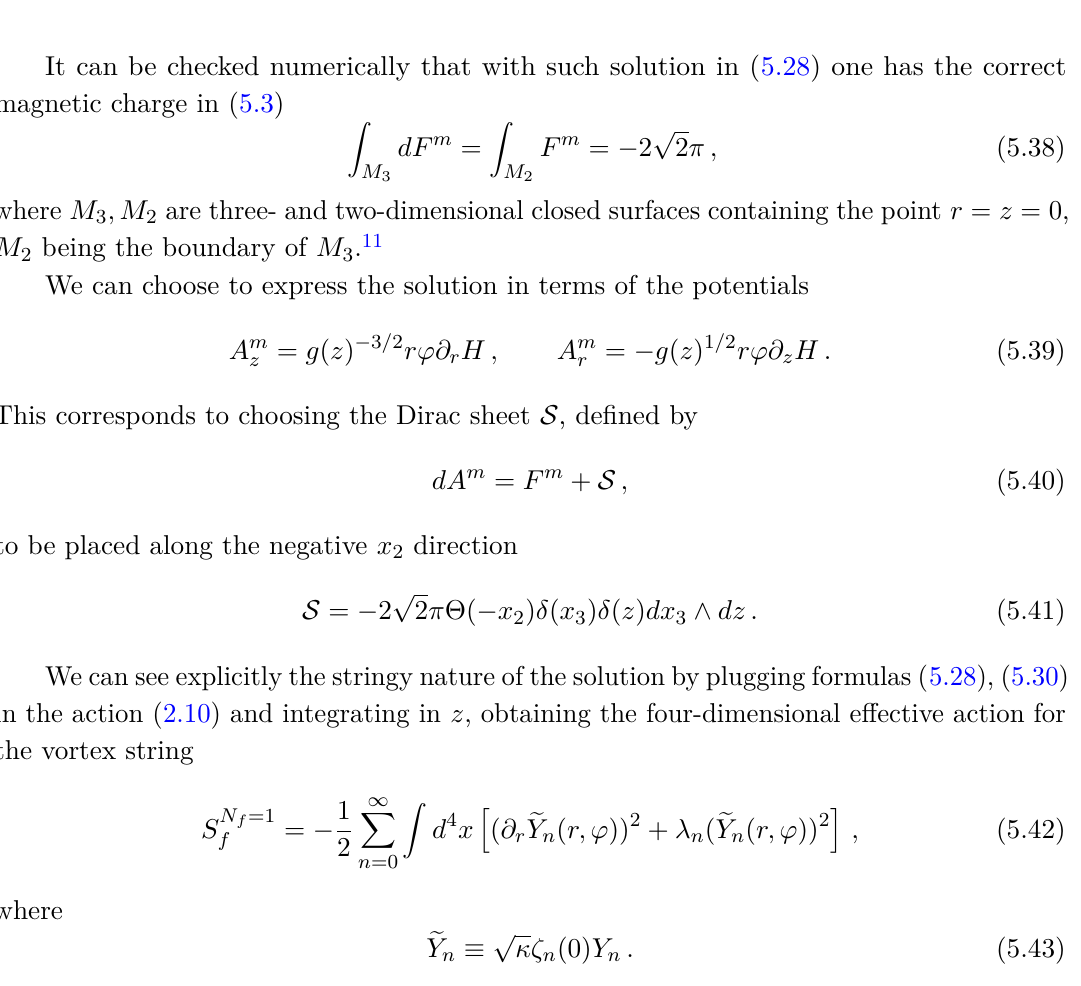
Figure 5 . Left: the function H ( r, z ) obtained from the first six (even) modes in (5.30). Right: the √ profile of − 2 η 0 for m WV /M KK = 0 . 3 f π